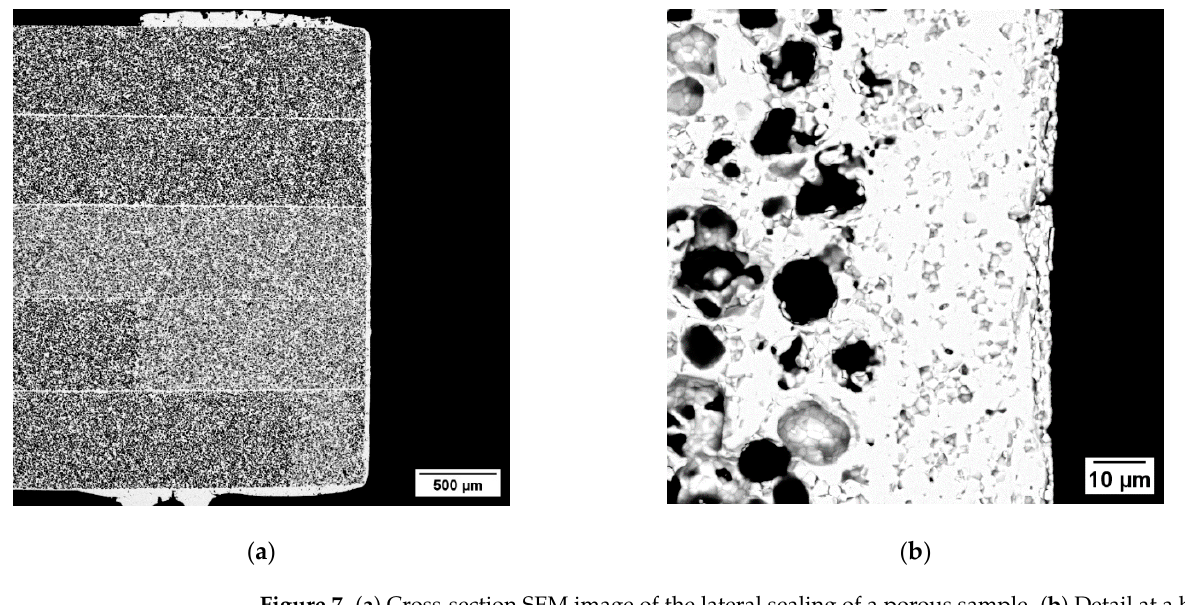
Figure 7. ( a ) Cross-section SEM image of the lateral sealing of a porous sample. ( b ) Detail at a higher magnification of the sealing layer.